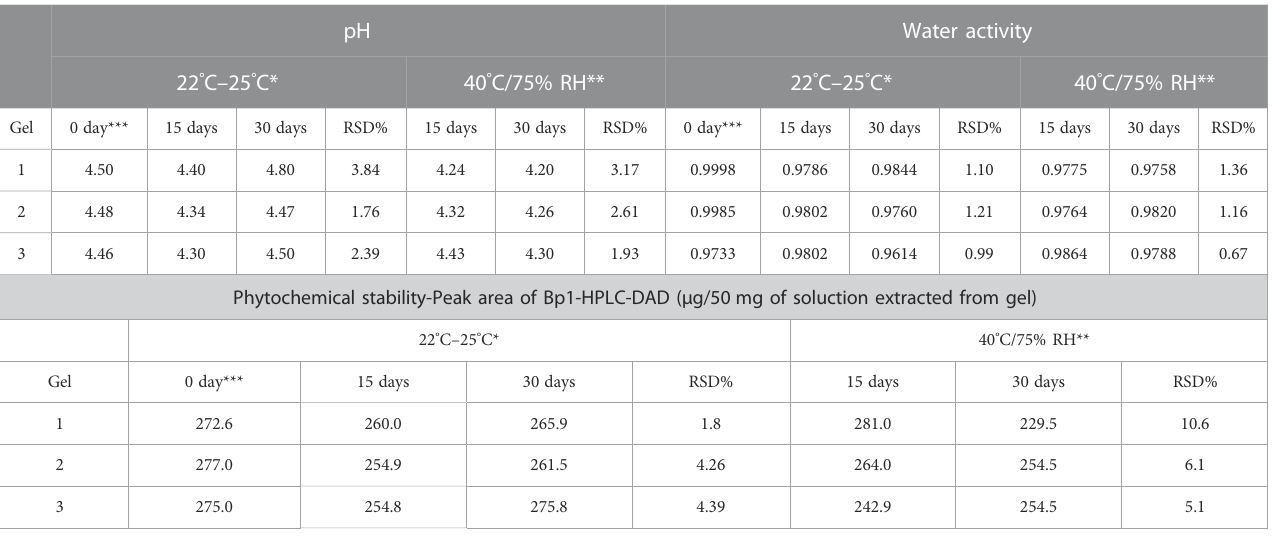
TABLE 4 Stability study of formulation in gel containing B. pinnatum leaf extract at